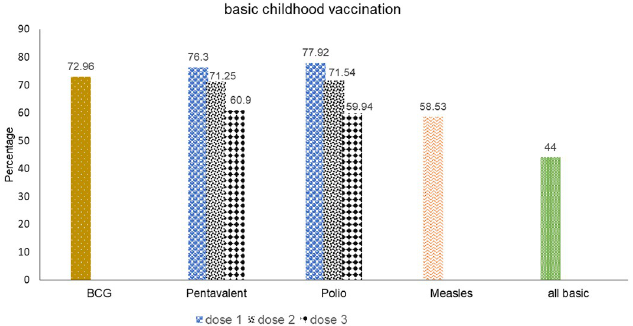
Fig 1. Prevalence of complete basic childhood vaccination and its components among children aged 12–23 months in Ethiopia, EMDHS 2019.